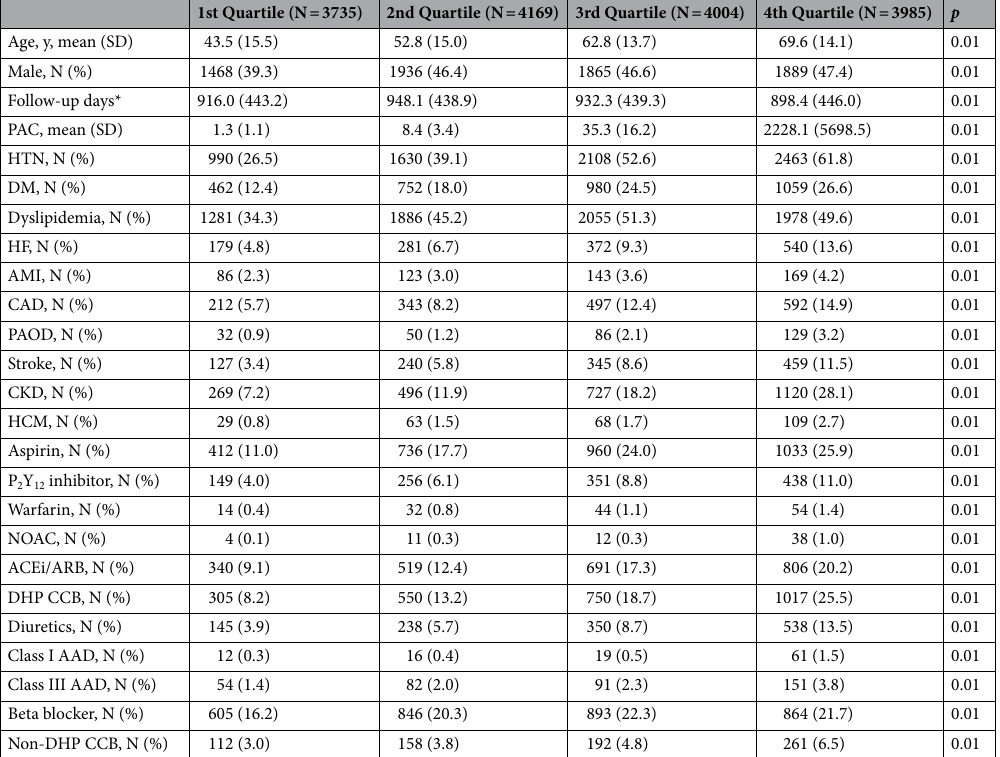
Table 2. Demographic and clinical characteristics of each quartile group. Abbreviations: AAD antiarrhythmic drug, ACEi/ARB angiotensin-converting enzyme inhibitor/angiotensin receptor blocker, AMI acute myocardial infarction, CAD coronary artery disease, CKD chronic kidney disease, DHP CCB dihydropyridine calcium channel blocker, DM diabetes mellitus, HCM hypertrophic cardiomyopathy, HF heart failure, HTN hypertension, Non-DHP CCB non-dihydropyridine calcium channel blocker, PAOD peripheral arterial occlusive disease, PAC premature atrial complex, NOAC novel oral anticoagulant. *Represents median follow-up days(SD).